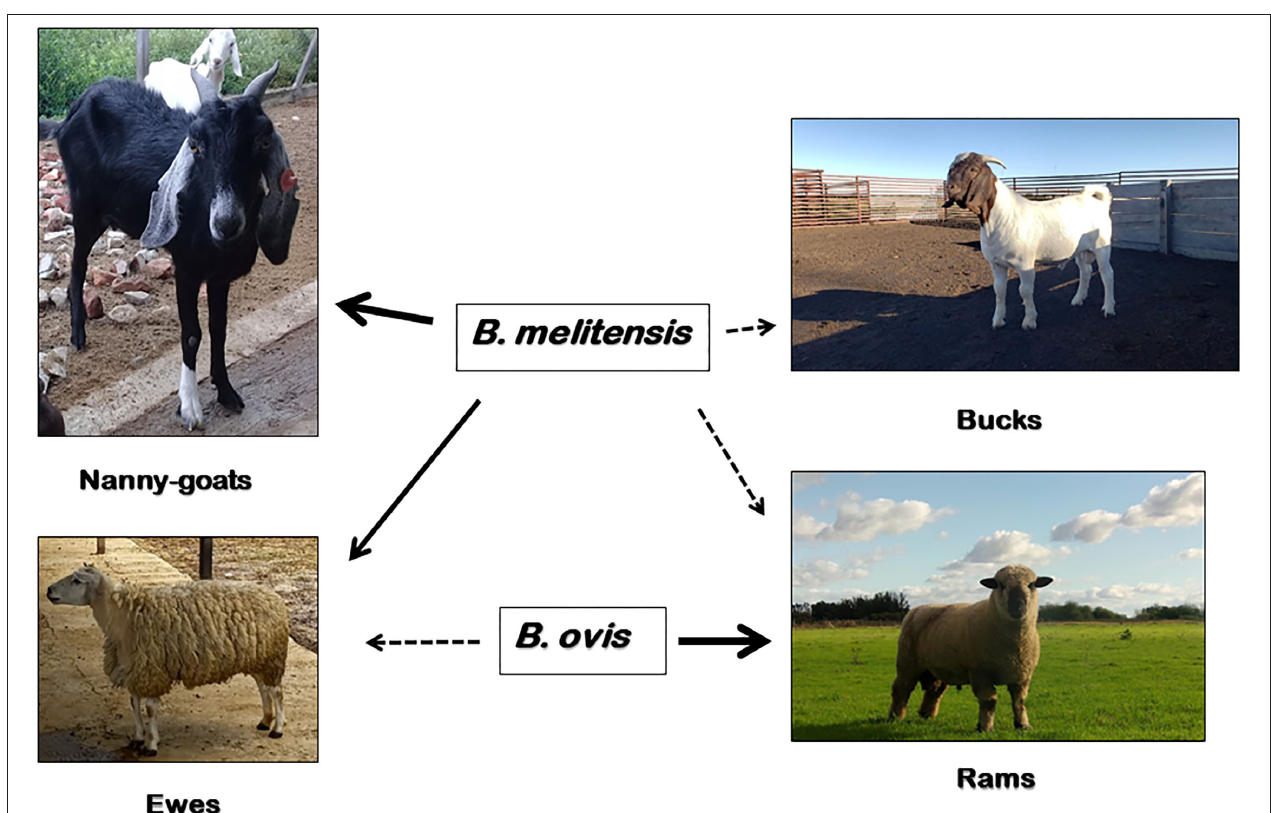
FIGURE 1 | Susceptibility of domestic small ruminants to B. melitensis and B. ovis infection. B. melitensis cause abortion, stillbirths and the birth of weak offspring in goats and sheep (solid arrow); and less commonly, epididymo-orchitis in bucks and rams (dashed arrow). Moreover, B. ovis affect rams almost exclusively (solid arrow), causing epididymitis and occasionally abortions in ewes and an increase in perinatal death (dashed arrow). In addition to sheep and goats, B. melitensis has a wide range of natural susceptible host species, including humans. Other than domestic sheep, B. ovis has only been isolated from naturally-acquired infections of farmed red deer ( Cervus elaphus ), but experimental infections have been established in goats, Rocky Mountain bighorn sheep ( Ovis canadensis canadensis ) and white-tailed deer ( Odocoileus virginianus) .